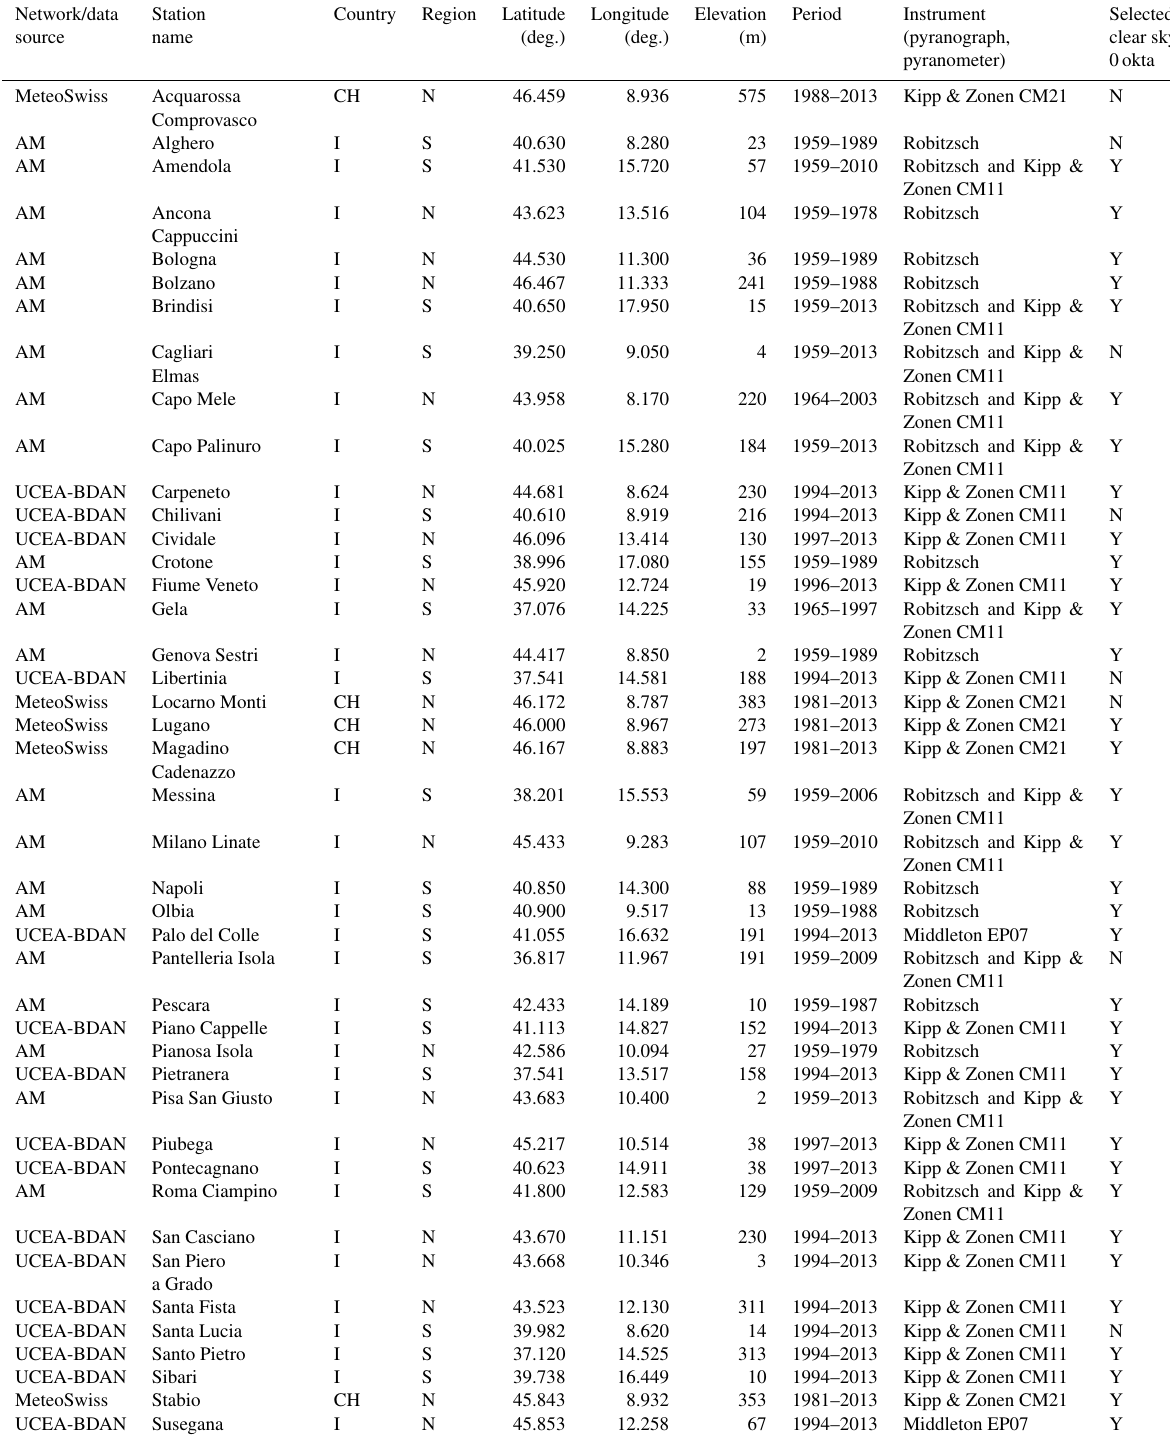
Table 1. Details on the network, station location, instruments and length of the records in the SSR dataset. The last column shows which records have been considered to calculate the regional mean under clear-sky conditions (see Sect. 2.4).